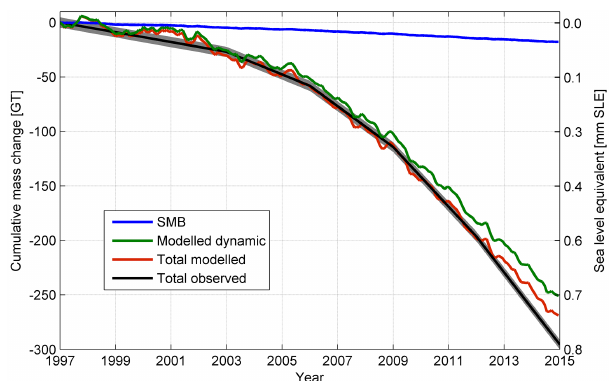
Figure 4. Modelled and observed cumulative mass change for Jakobshavn Isbræ. The blue curve represents the mass change due to SMB (Noël et al., 2015) after the 1960–1990 baseline is removed. The green curve represents the modelled ice dynamics mass change (i.e. modelled mass change minus SMB change). The red curve rep- resents the total modelled mass change including both SMB and ice dynamic changes. The black curve with grey error limits repre- sents the total observed mass change including both SMB and ice dynamic changes. The modelled mass change for the period 1997– 2014 is ∼ 269Gt and the observed mass change is ∼